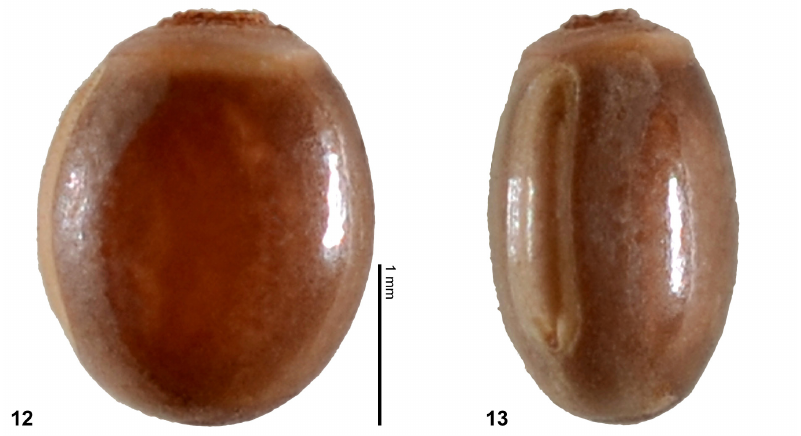
Figs 12–13. Lobolibethra carbonelli sp. nov. 12 . Egg, PT: lateral view (FH, 0569-E1); 13 . Egg, PT: dorsal view (FH,